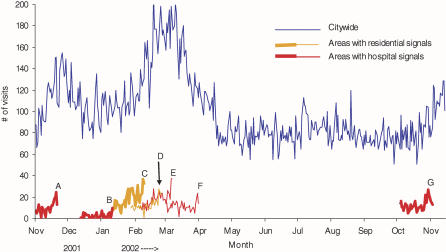
The Daily Temporal Pattern of Emergency Department Diarrhea Syndrome Visits in New York City, 1 November to 14 November 2002For the citywide line (blue), daily counts are provided for the whole year. For each local area with a signal, daily counts are provided for the 1-mo period leading up to and including the day of the signal. The four stronger signals are depicted with thicker lines.